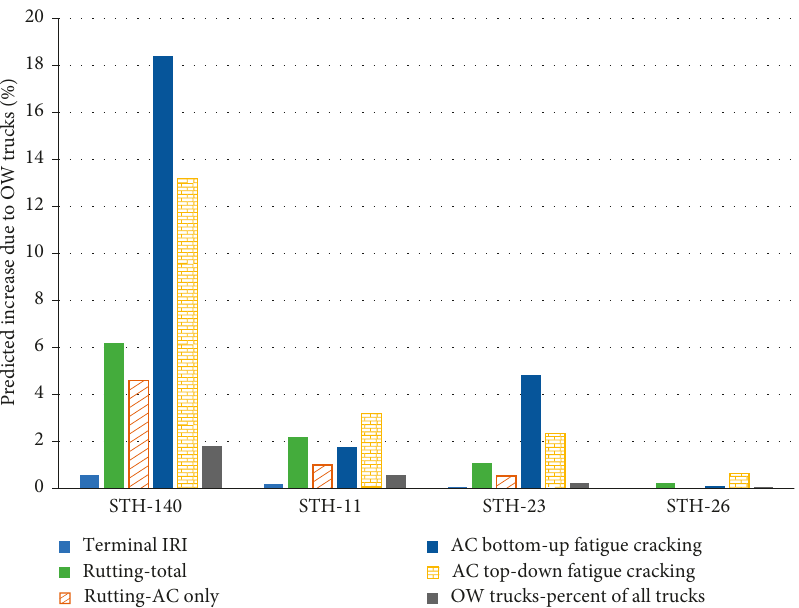
Figure 8: Relative increases in pavement distresses predicted by ME analyses due to the addition of OW vehicles to baseline traffic and relative proportion of OW